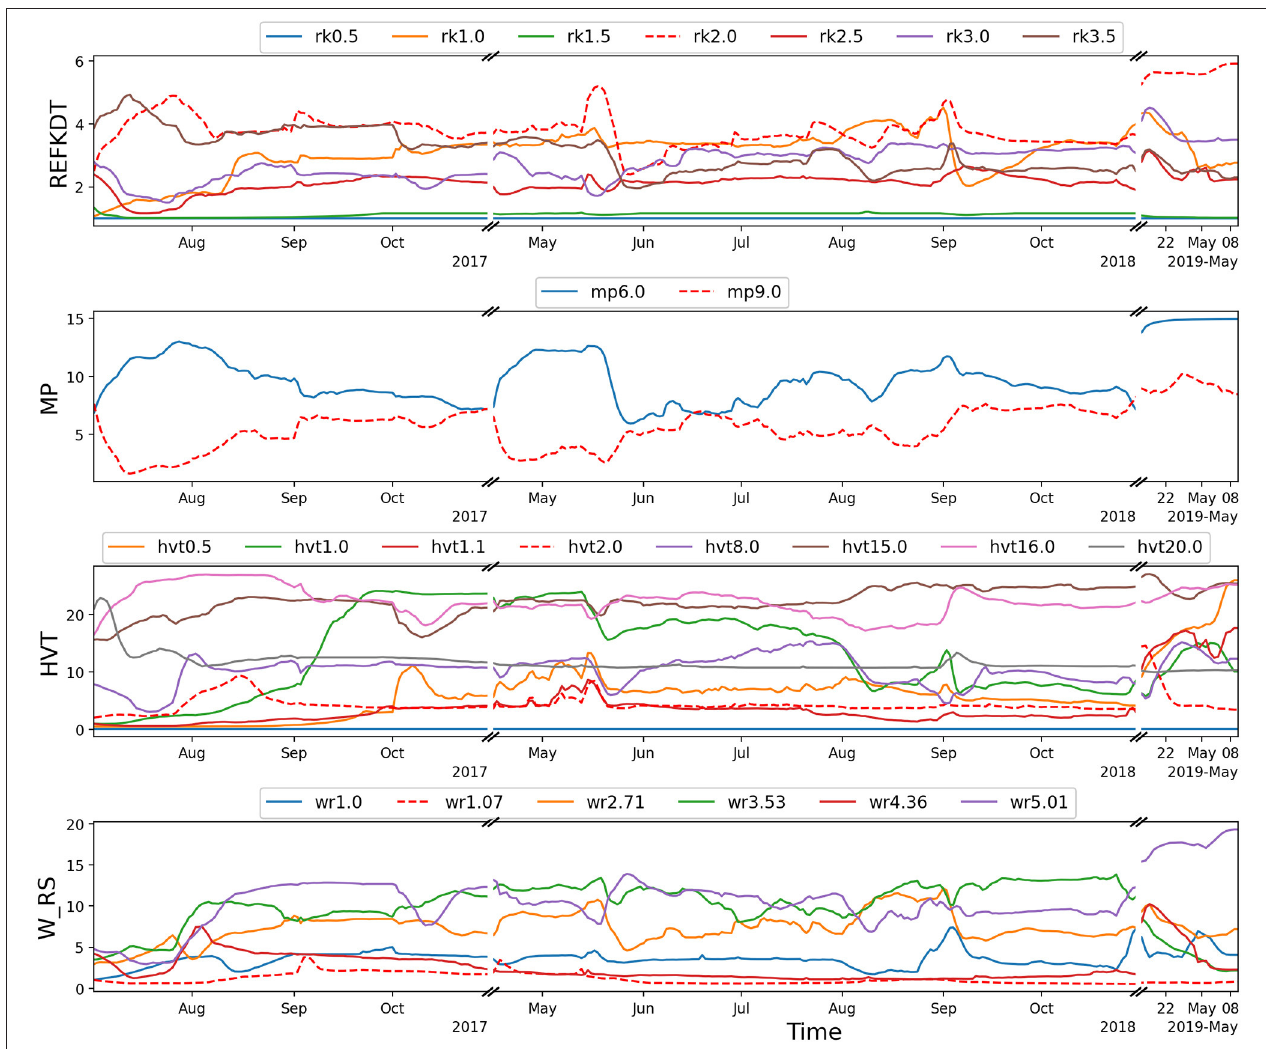
FIGURE 4 | Parameter updates for REFKDT, MP, HVT, and W_RS during the STP assimilation run. The parameters representing the Fendt CRNP are printed as dashed red